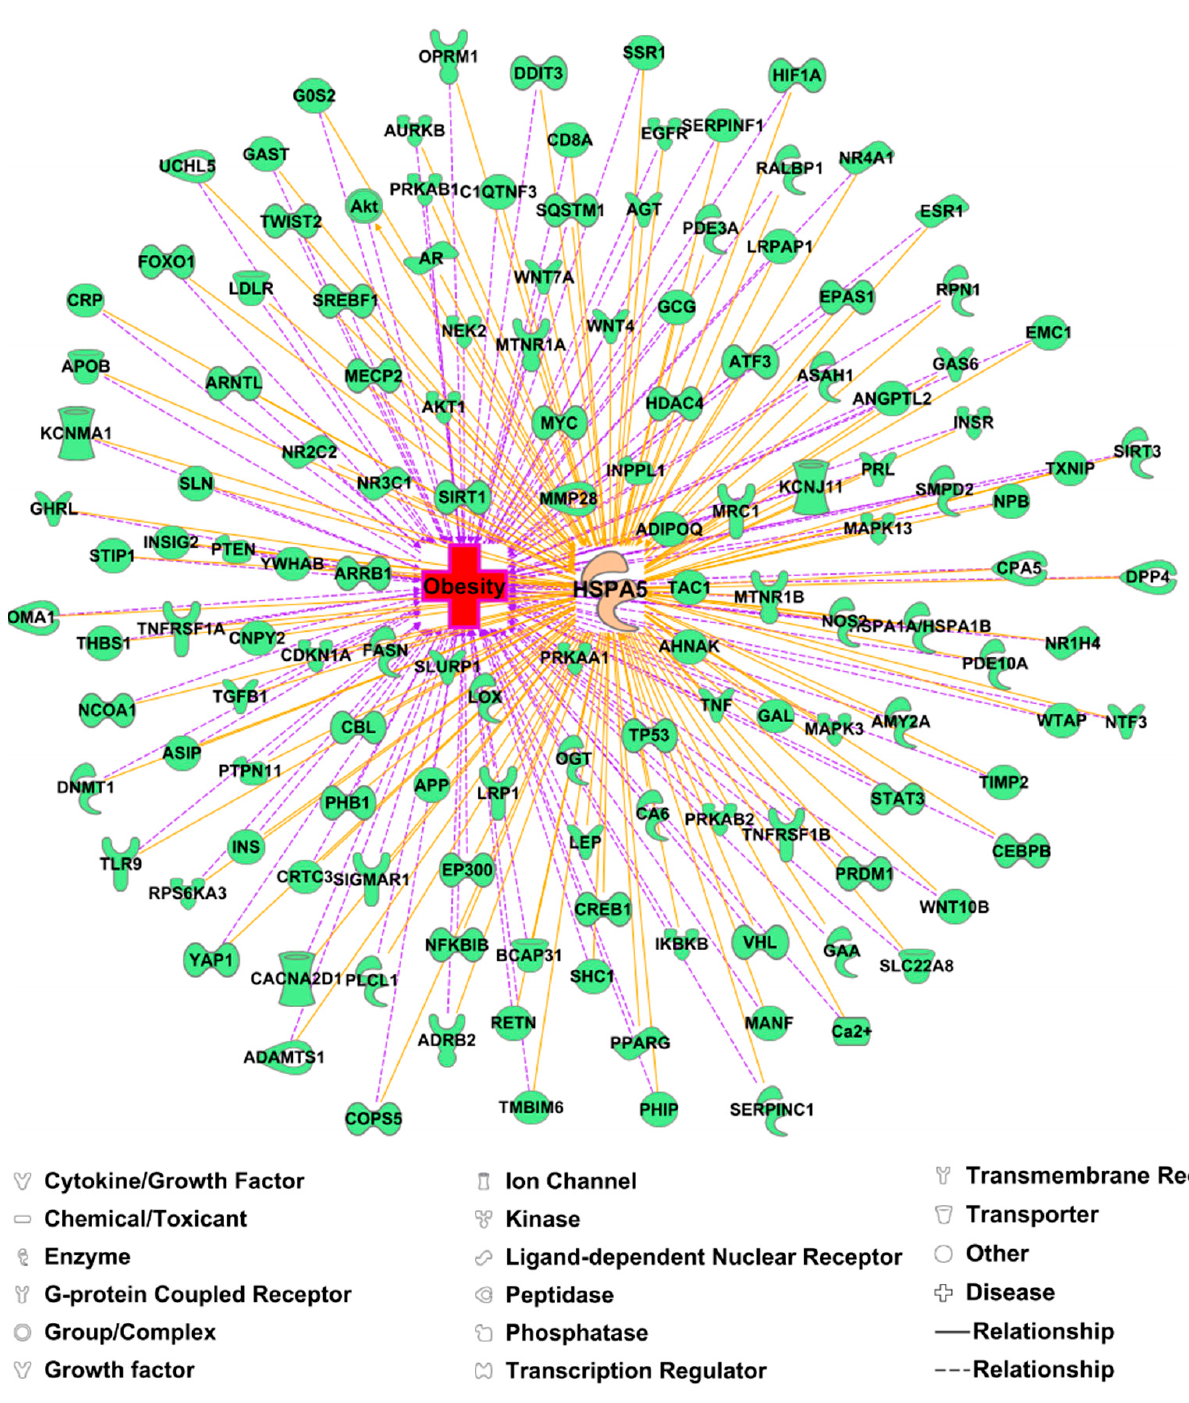
Figure 2. Ingenuity Pathway Analysis (IPA) result of GRP78 (HSPA5) with its interacting proteins relevant to obesity. Using “obesity” as the keyword, 1216 proteins, including HSPA5 (GRP78), were obtained from the IPA database. According to the analysis of the “Build-Path Explorer” module, 139 molecules have interactions with HSPA5. Table 1. List of proteins that directly bind GRP78 [47,51–68].